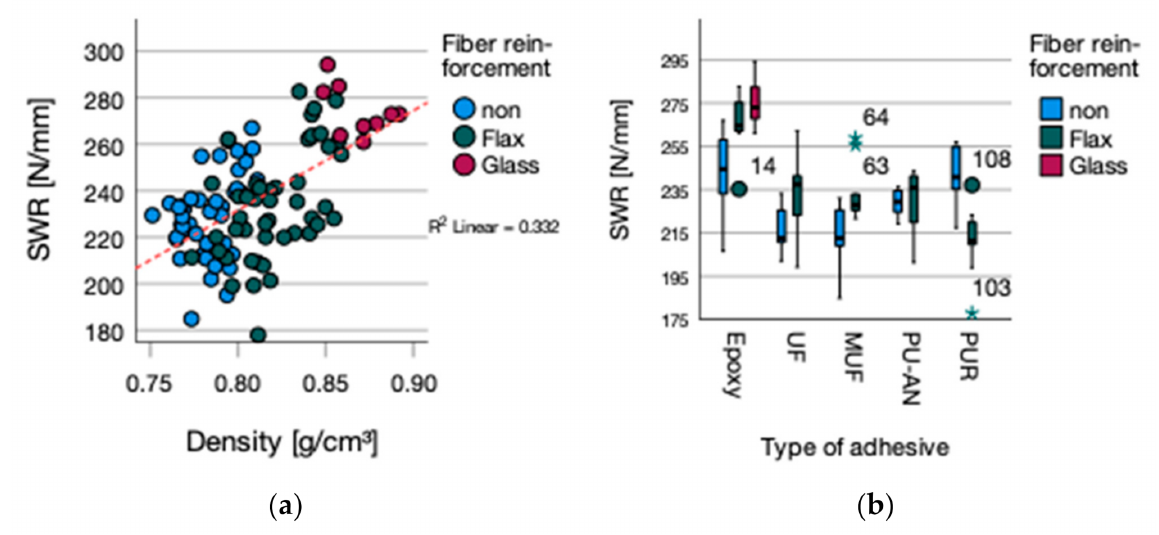
Figure 7. ( a ) SWR vs. density and ( b ) SWR grouped by type of